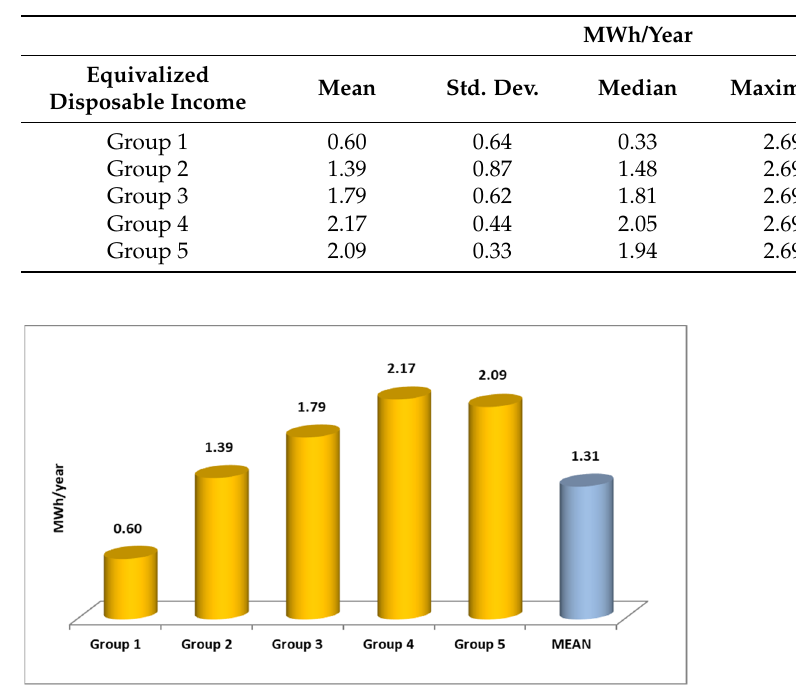
Figure 12. Mean energy consumption per inhabitant by group of cities without the influence of climate.